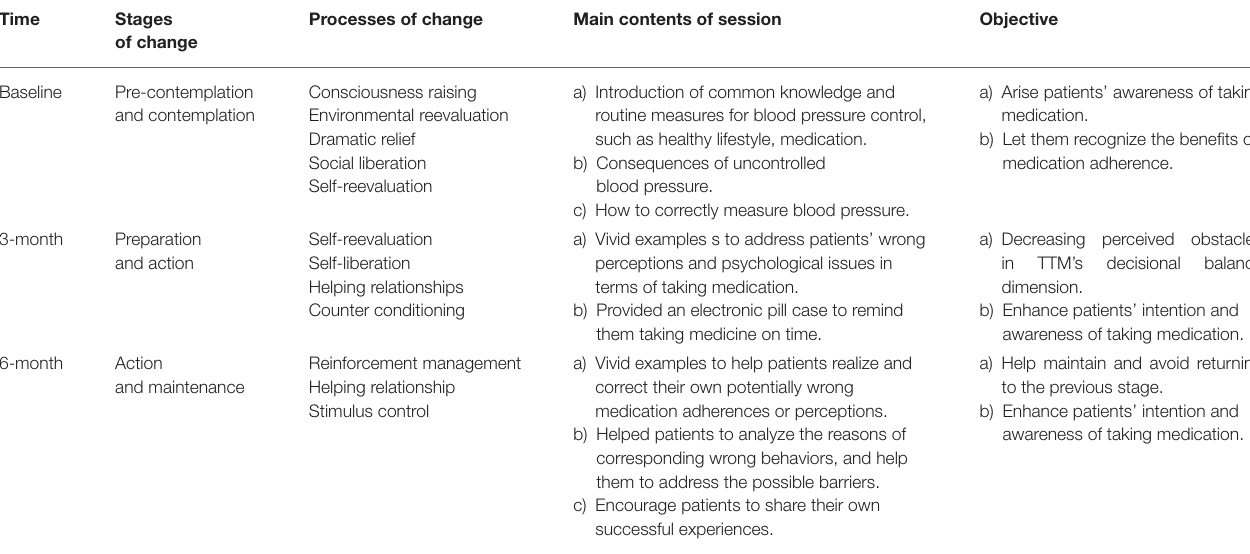
TABLE 1 | Applying transtheoretical model (TTM) in design of the intervention.